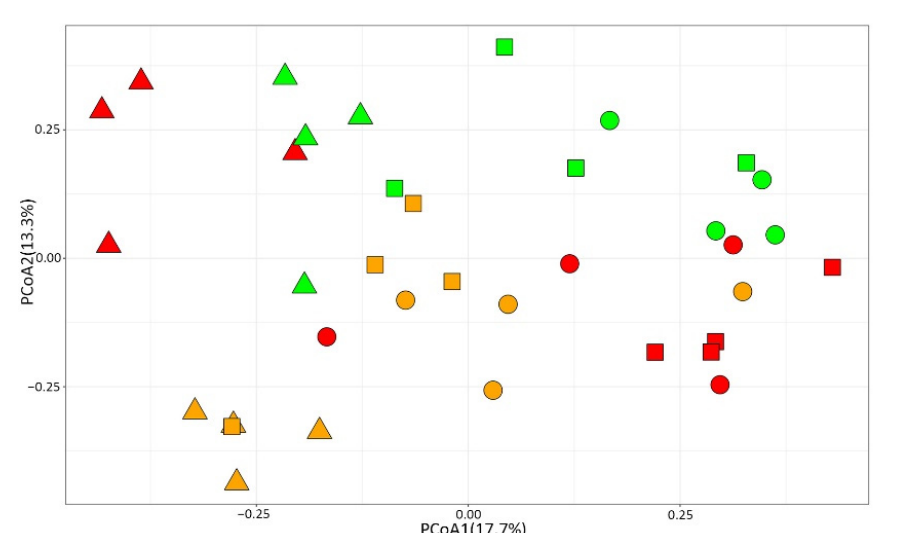
Figure 5. Principal Coordinates Analysis (PCoA) ordination plot of the mollusc assemblages sampled at the Vu site. Colours indicate pH conditions: green = control pH; orange = low pH; red = extremely low pH. Microhabitats are indicated through circles (Canopy), triangles (Bottom), and squares (Matte). The observed differences in the composition of mollusc assemblages and Table 6. Results of PERMANOVA on mollusc assemblages found on P. oceanica meadow at the Vu site. Significant values are highlighted in bold.